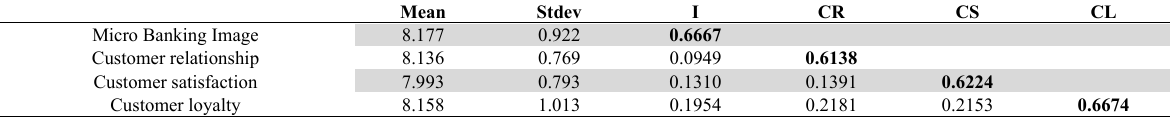
Discriminant validity: AVEs versus cross-construct squared